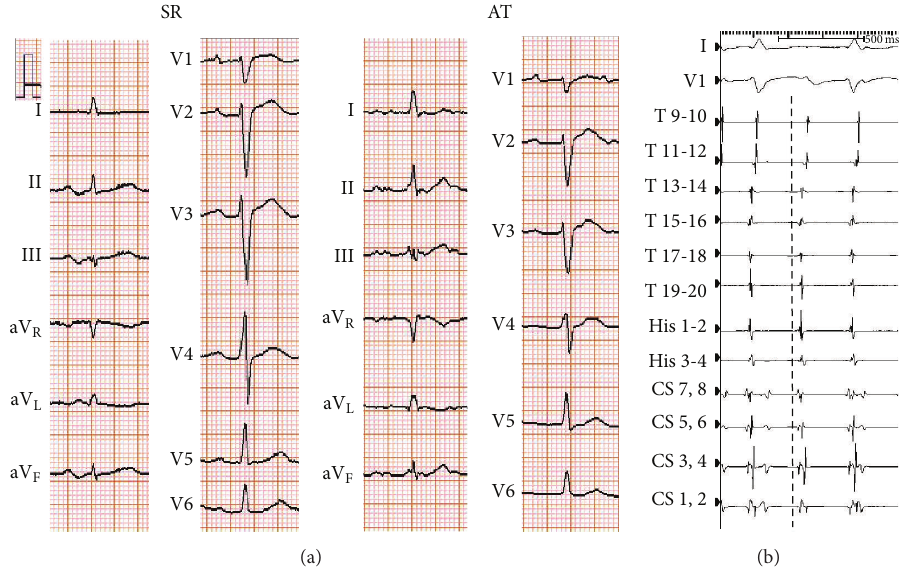
Figure 1: (a) The left panel shows a 12-lead electrocardiogram (ECG) in sinus rhythm (SR) and the right panel shows that of atrial tachycardia (AT). (b) Intracardiac ECG during AT. T indicates the Halo catheter. Numbers 9-10 are the distal electrodes located at the lateral tricuspid annulus (TA). Numbers 19-20 are located at the anteroseptal TA. His 1-2 is the distal electrode of His. CS indicates the electrode catheter in the coronary sinus (CS). CS 1-2 is the distal electrode and CS 7-8 is located at the CS ostium. The dotted line indicates the earliest activity of AT recorded at CS